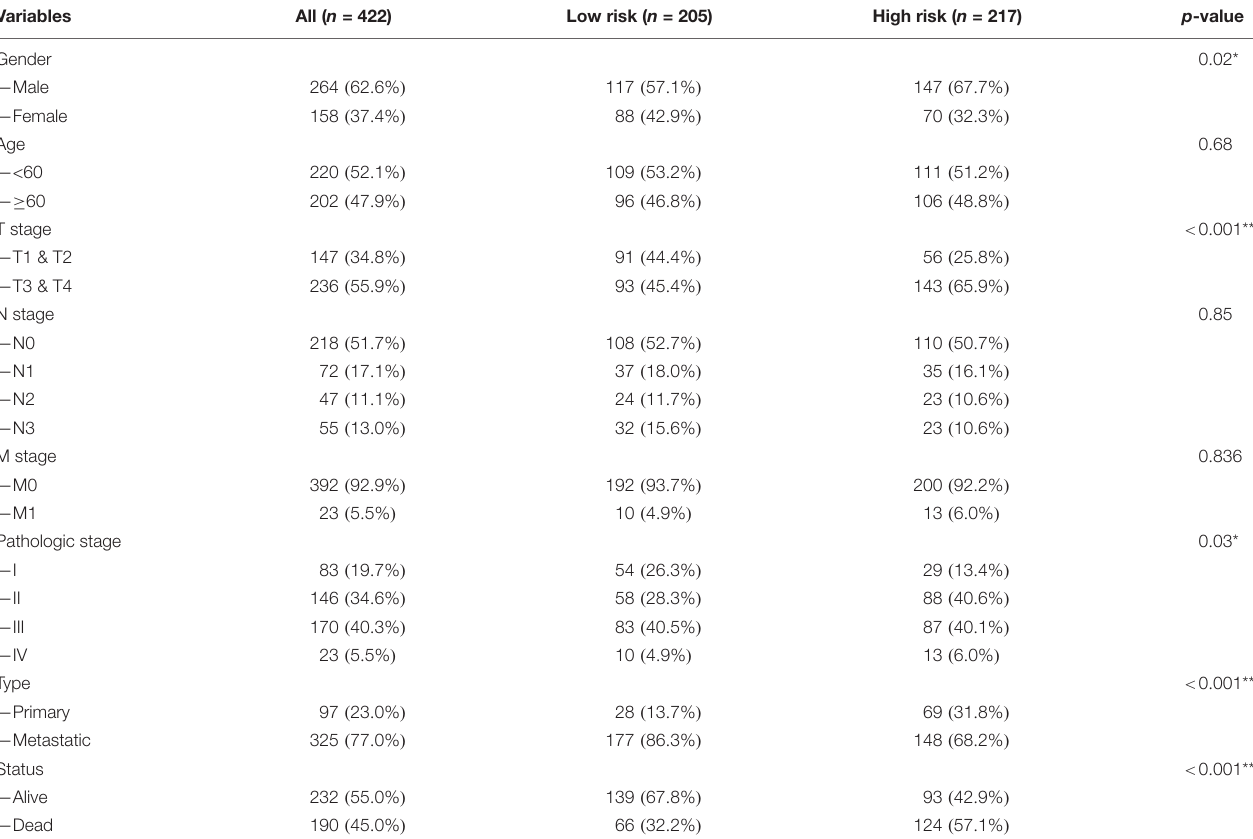
TABLE 1 | Baseline data of SKCM patients in TCGA